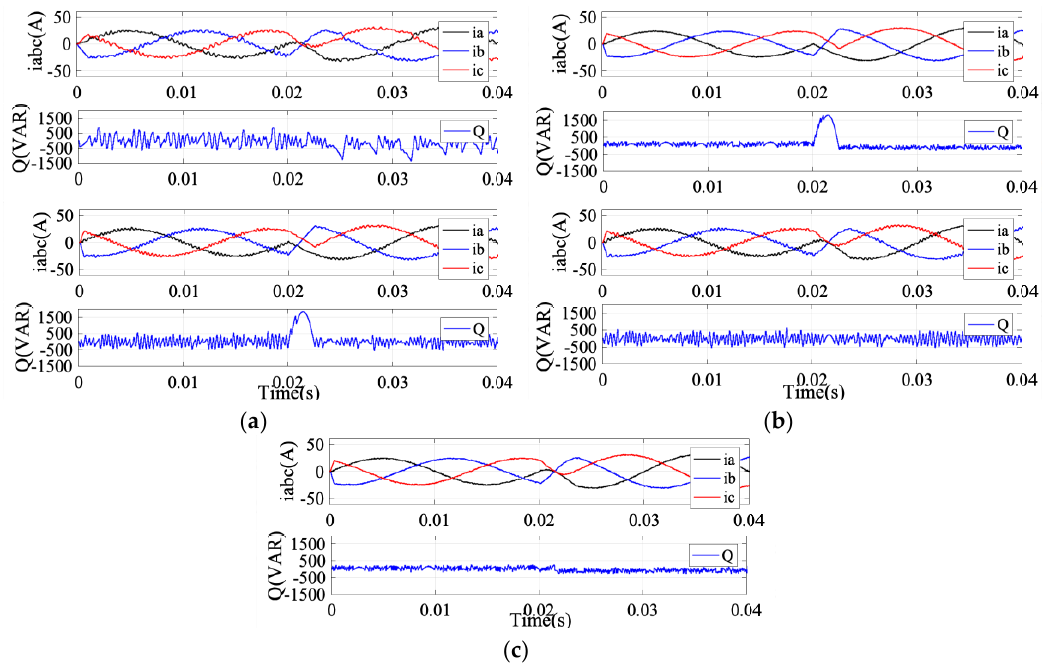
Figure 5. From top to bottom. (a) CDPC three-phase currents, CDPC reactive powers, CMPC-I three- phase currents, CMPC-I reactive powers; (b) CMPC-II three-phase currents, CMPC-II reactive three-phase currents, CMPC-I reactive powers; ( b ) CMPC-II three-phase currents, CMPC-II reactive powers, MMPC-I three-phase currents, MMPC-I reactive powers; (c) MMPC-II three-phase currents, powers, MMPC-I three-phase currents, MMPC-I reactive powers; ( c ) MMPC-II three-phase currents, MMPC-II reactive powers. MMPC-II reactive